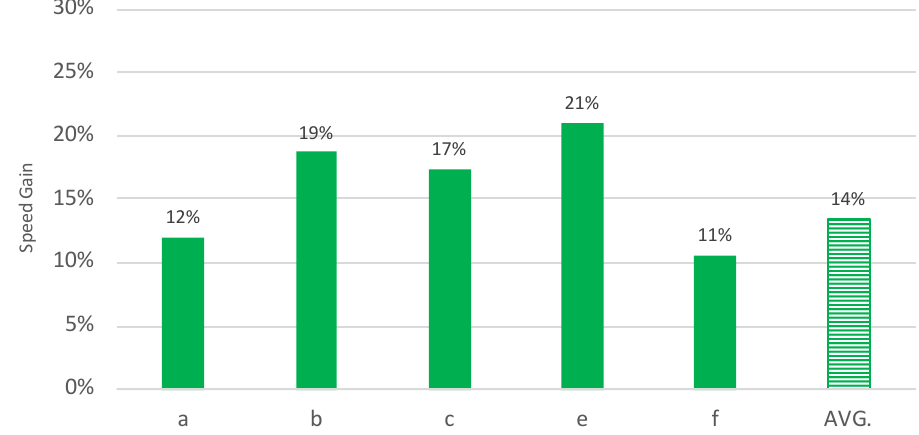
Figure 6. Relative speed gains when using MT for five translators from the Finnish language